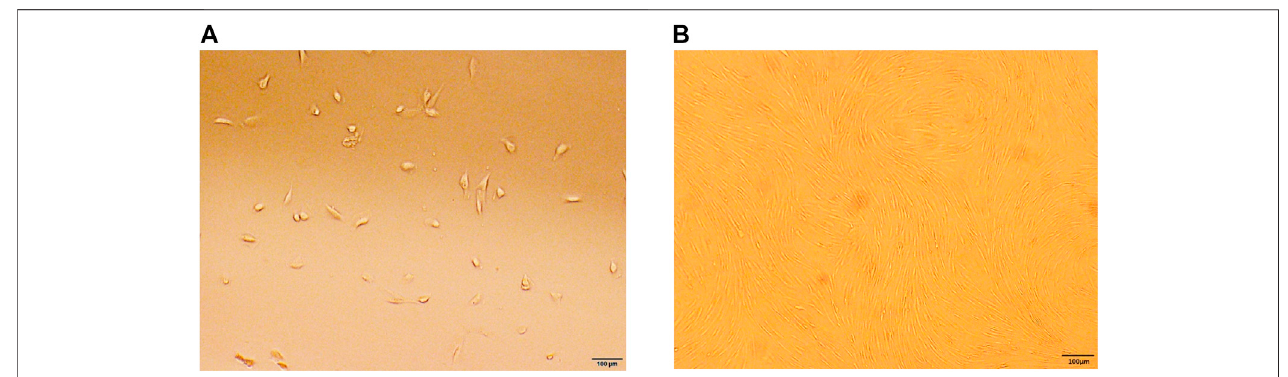
FIGURE 1 | Characteristics of cell culture in vitro . (A) Human degenerative NP-MSCs exhibited a short, rod-like shape in primary culture. (B) Human degenerative NP-MSCs showed uniform spindle fi lament spiral growth after subculture.